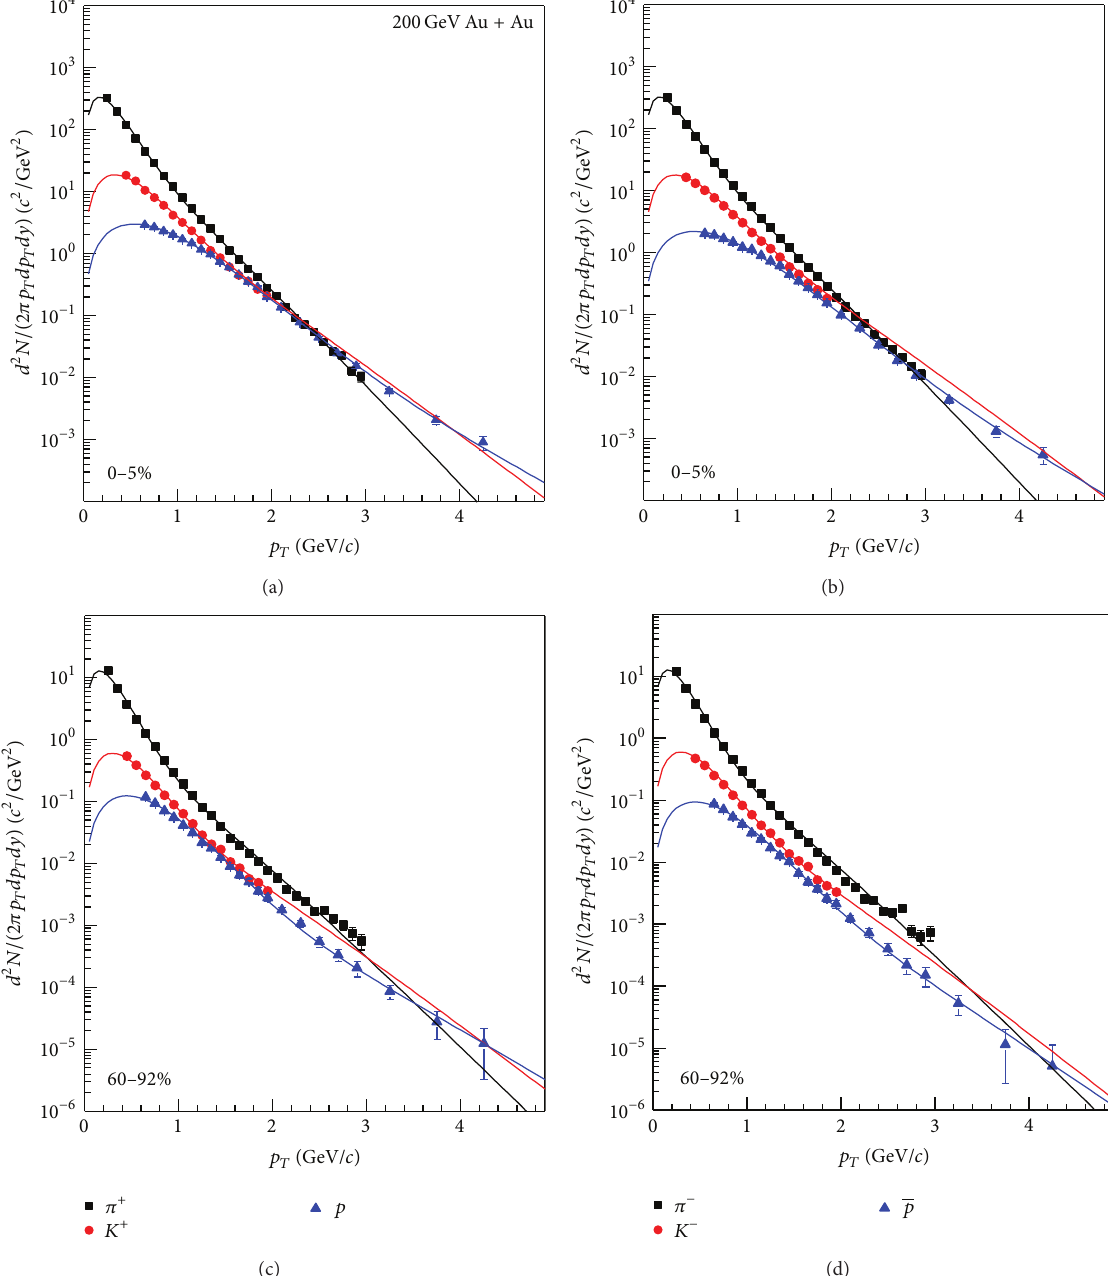
Figure 2: The same as Figure 1, but showing the results in Au-Au collisions at √𝑠 𝑁𝑁 = 200 GeV. The symbols represent the experimental data of the PHENIX collaboration